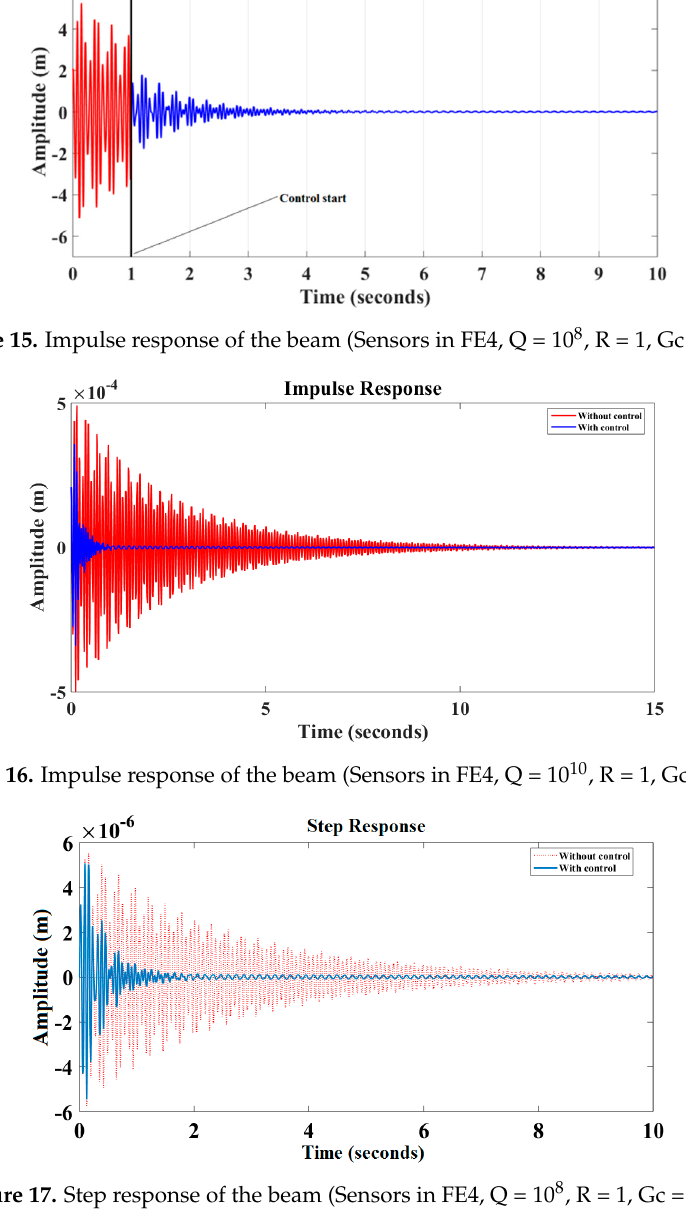
Figure 17. Step response of the beam (Sensors in FE4, Q = 10 8 , R = 1, Gc = 100).